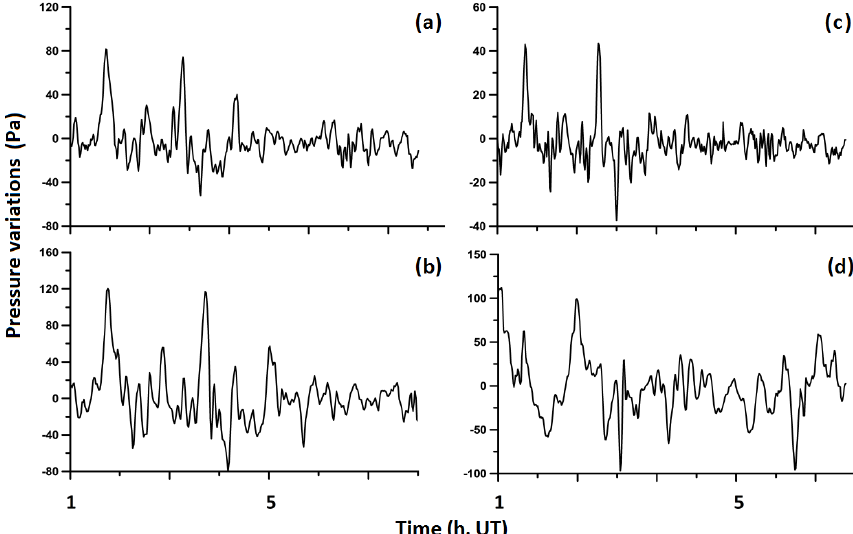
Figure 2. Pressure change at four stations in Moscow and environs for 18 July 2016: (a) IFA, (b) Moscow State University, (c) MosRentgen, and (d) ZRS.